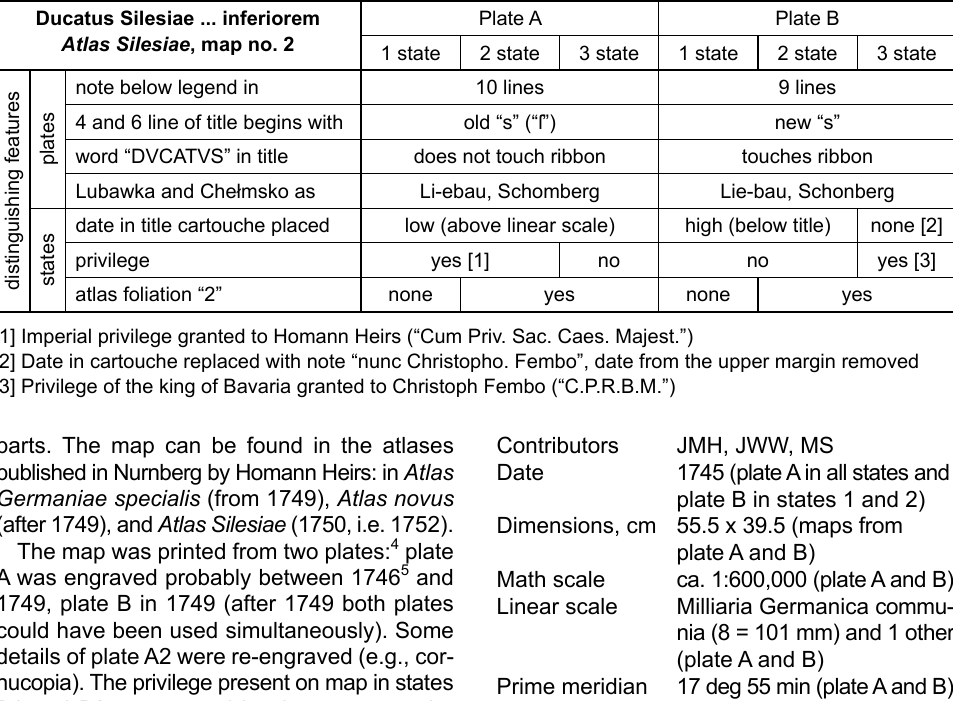
Table 2. Map of Lower Silesia – plates and